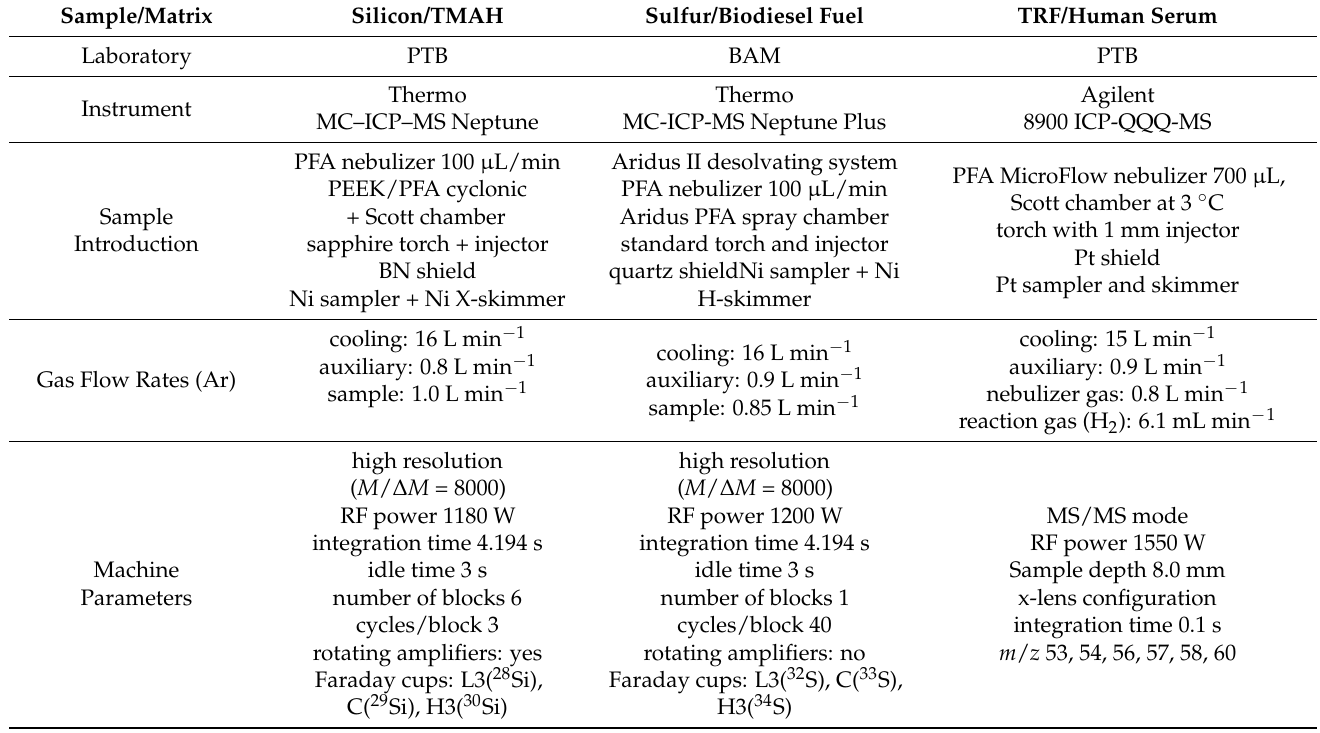
Table 1. Operation parameters of the mass spectrometric isotope ratio measurements applied for the three sample/matrix systems. (SP = spike; K = K